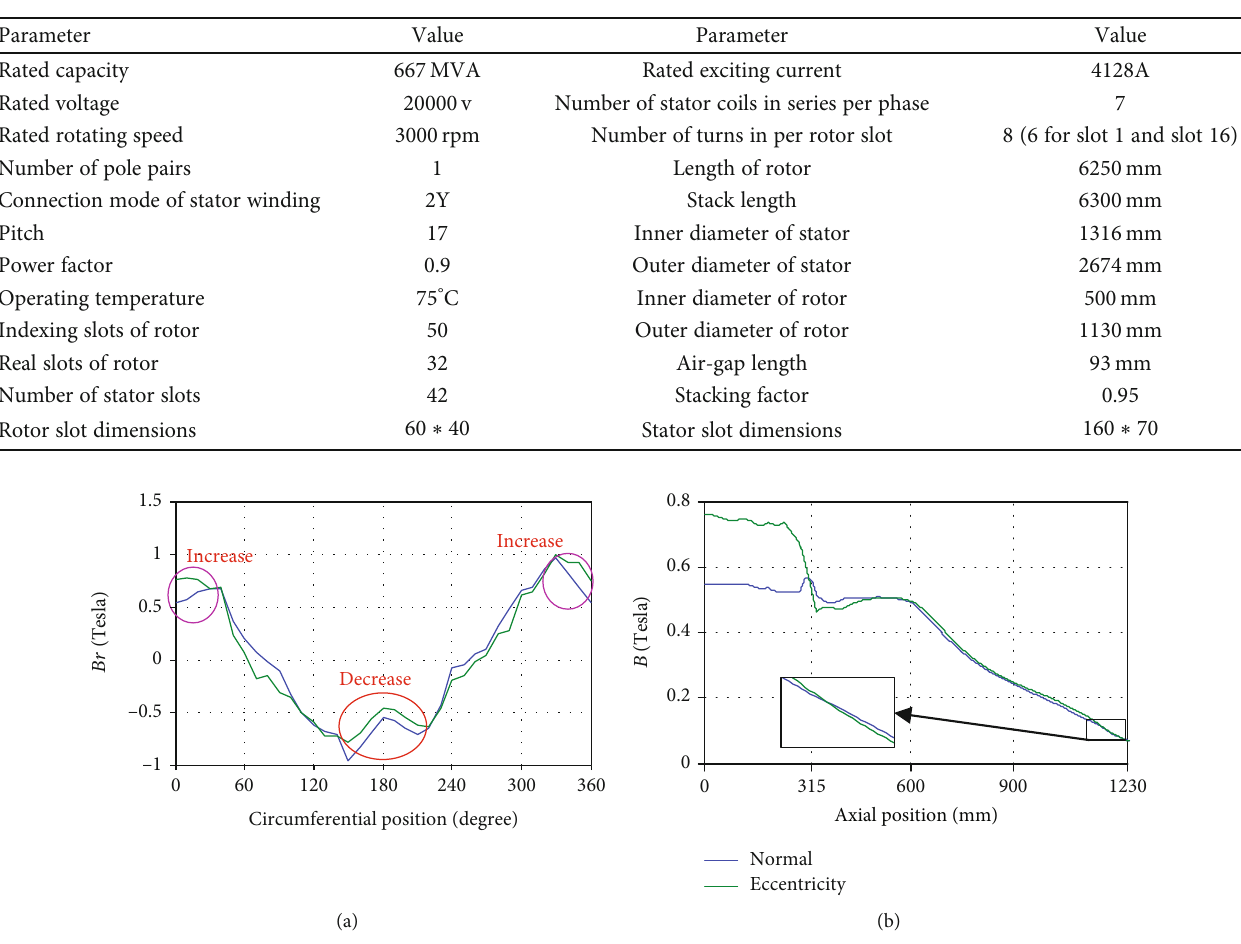
Table 1: Key parameters of the QFSN-600-2YHG turbo-generator.